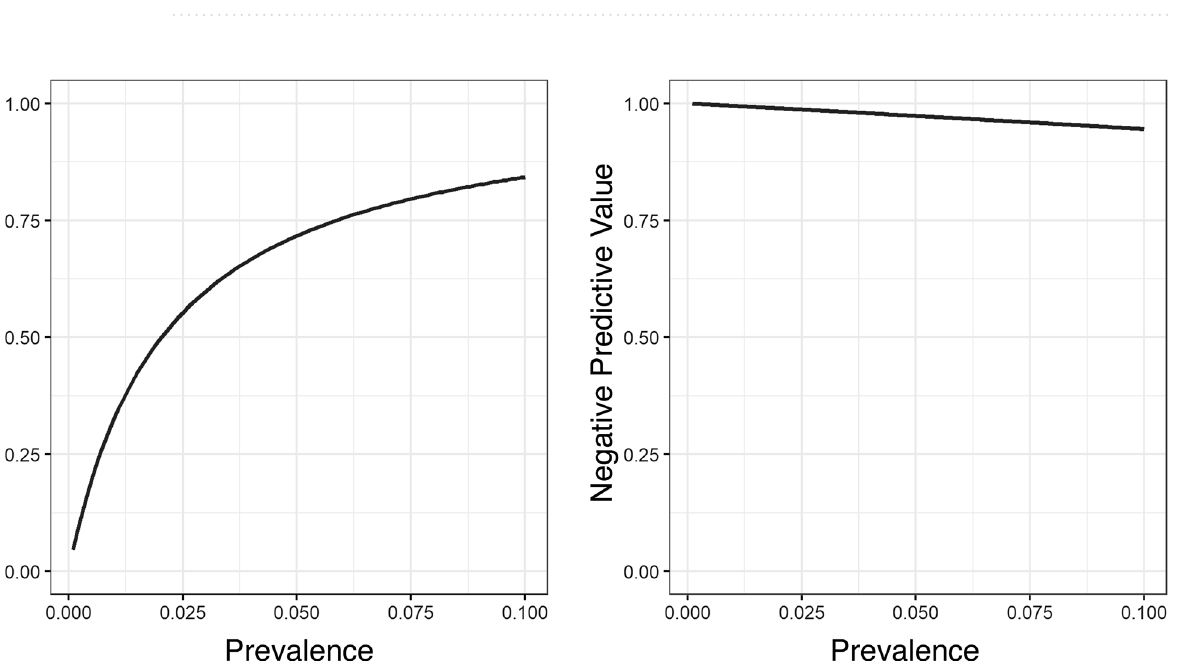
Table 6. CareStart test result sensitivity and specificity using Ct positivity threshold of < 30.